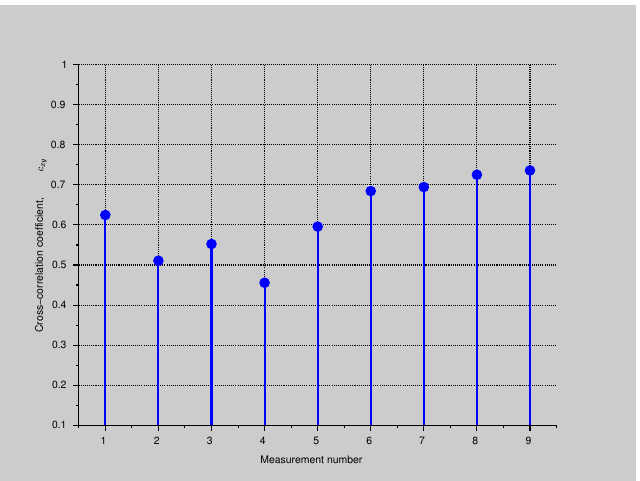
Figure 10. Cross correlation from all measurements: 1–3 axial, 4–6 horizontal and 7–9 vertical axes. Comparison with Other Measurement